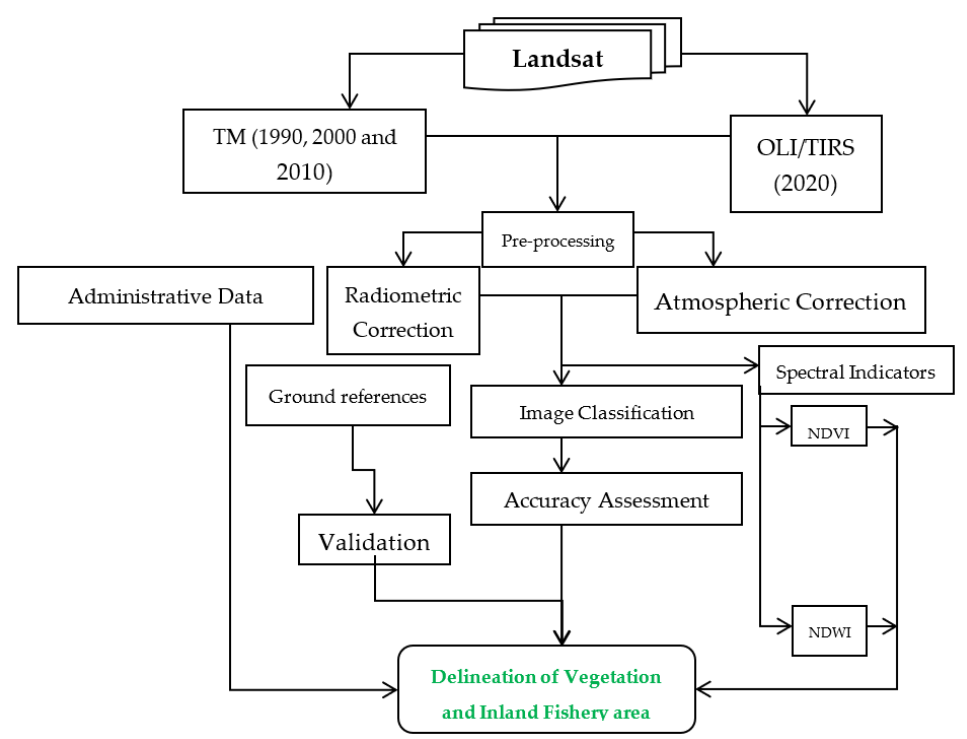
Figure 2. Entire methodology of the study area.